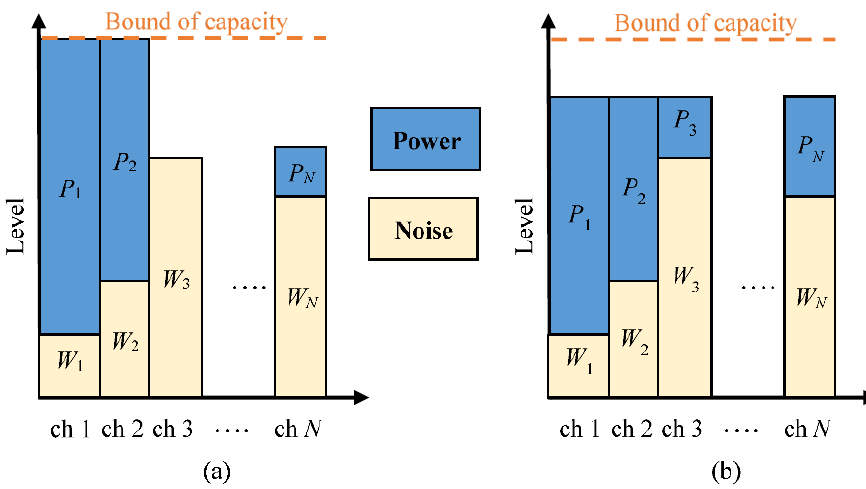
Figure 5. Paradigms of power allocation with ( a ) GA for one-by-one channel selection and ( b ) WF scheme for all channels with equal energy levels.